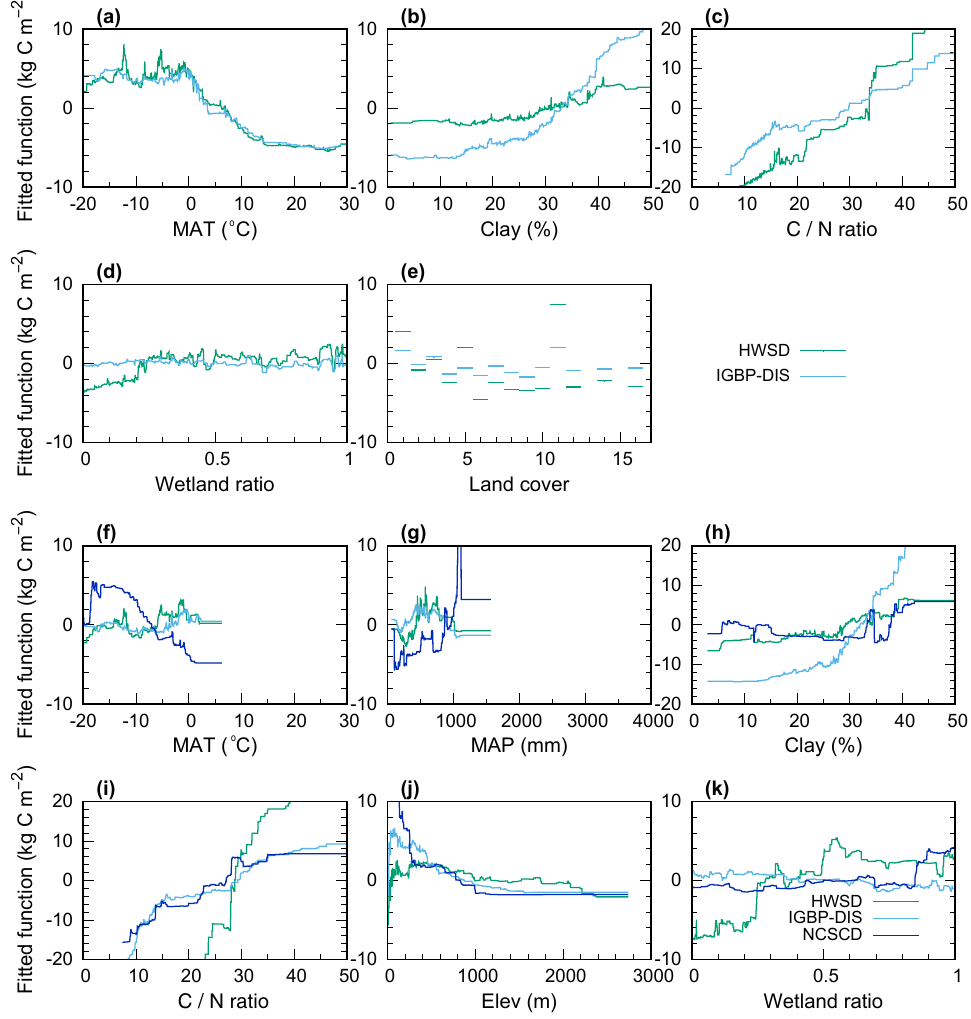
Figure 4. Effects of the most influential variables in the model of the soil carbon stock for each global (a–e) and northern (f–k) observational databases. The fitted functions were centered by subtracting their means. See Table A2 for land cover classifications. Because of the small number of data points, the results for “permanent snow and ice” are not shown (e) . The y -axis scales for clay and the CN ratio are different from those of other factors (c, h, i)